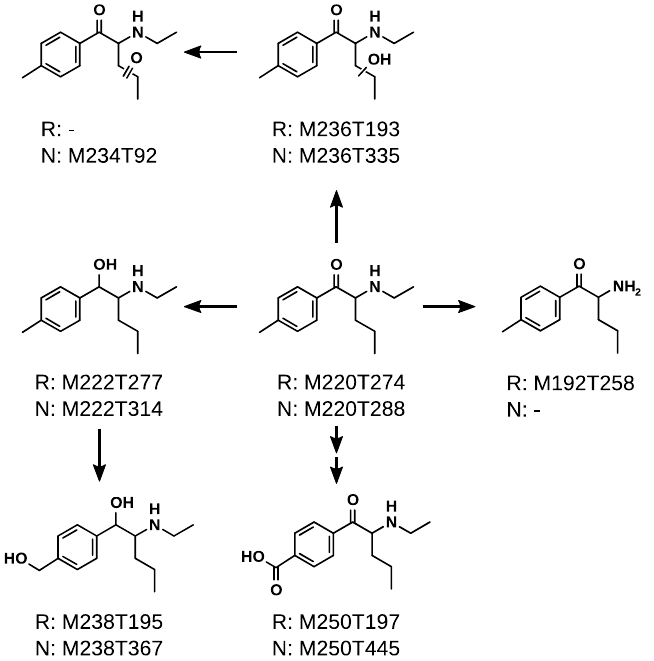
Figure 5. Proposed metabolic pathways of 4-MEAP in pHLM. Every metabolite is labeled by its feature identifier as detected within untargeted metabolomics analysis. R = reversed phase chromatography; N = normal phase chromatography.